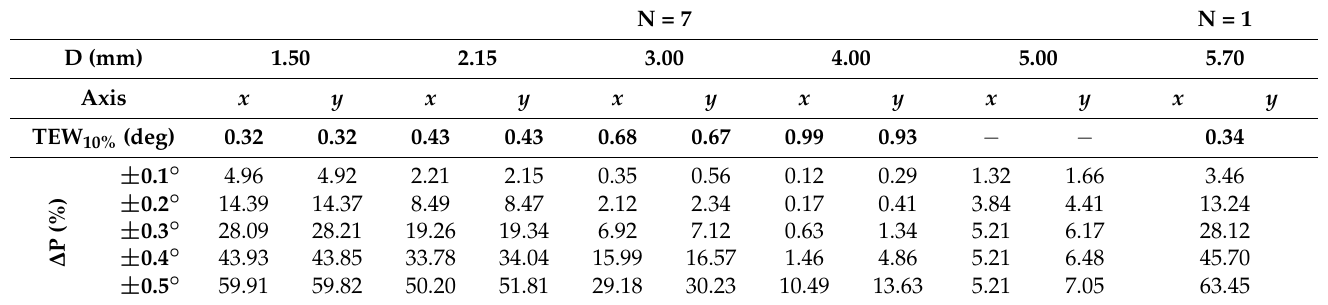
Figure 7. Total laser power in multimode regime as a function of the solar tracking error in the x - and y -axes, for different schemes tested. P max is the maximum total laser power achieved at optimal alignment by each of the schemes presented. Table 1. Tracking error width at 10% laser power loss (TEW 10% ) and Δ P at different solar tracking errors in the x - and y -axes, for different schemes tested. N = 7